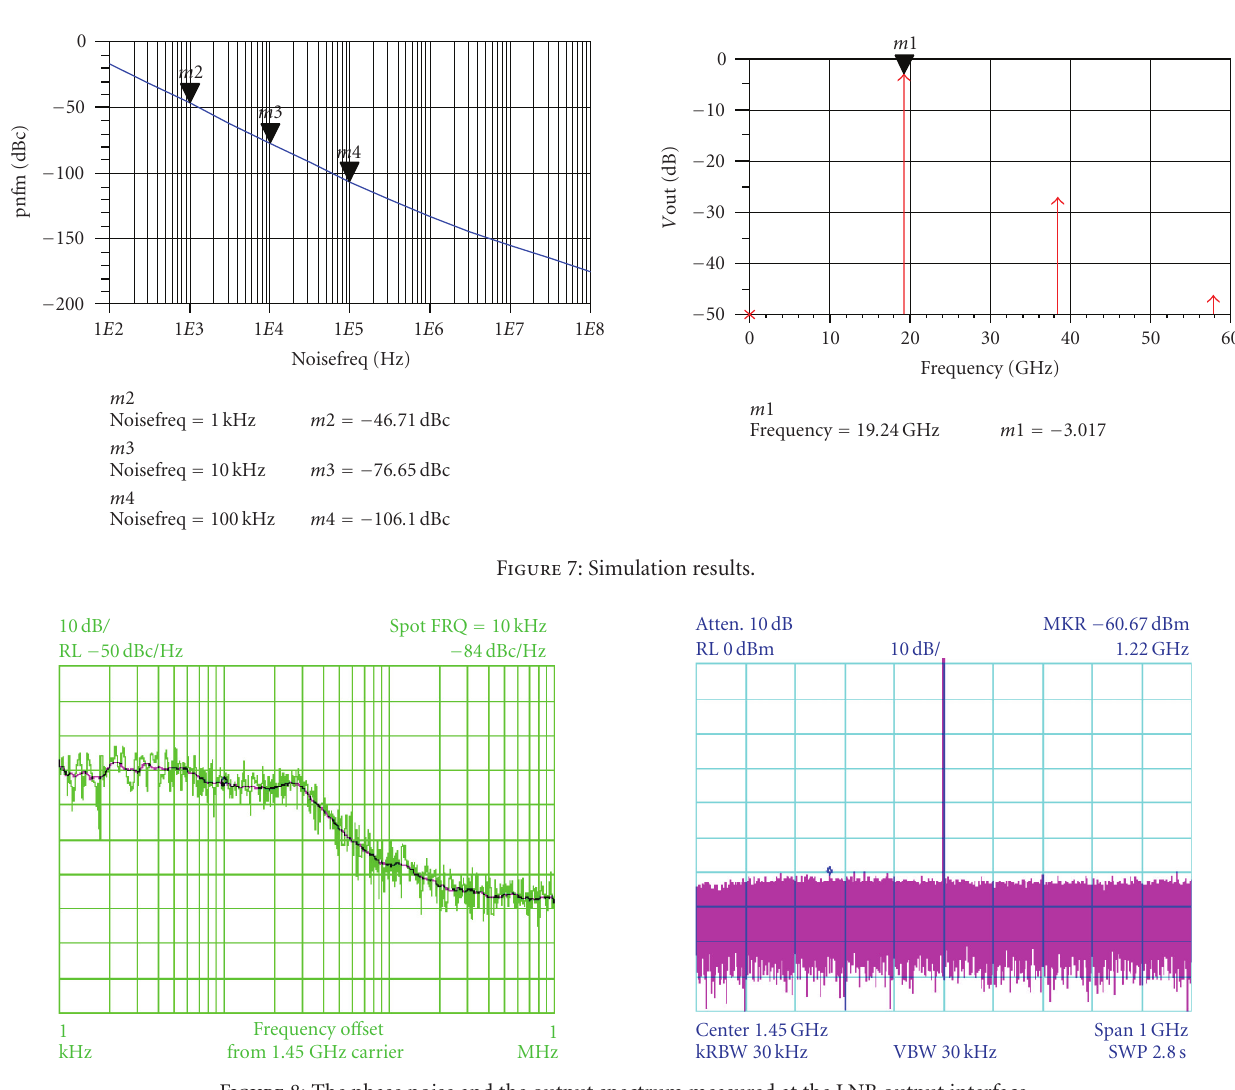
Figure 8: The phase noise and the output spectrum measured at the LNB output interface.